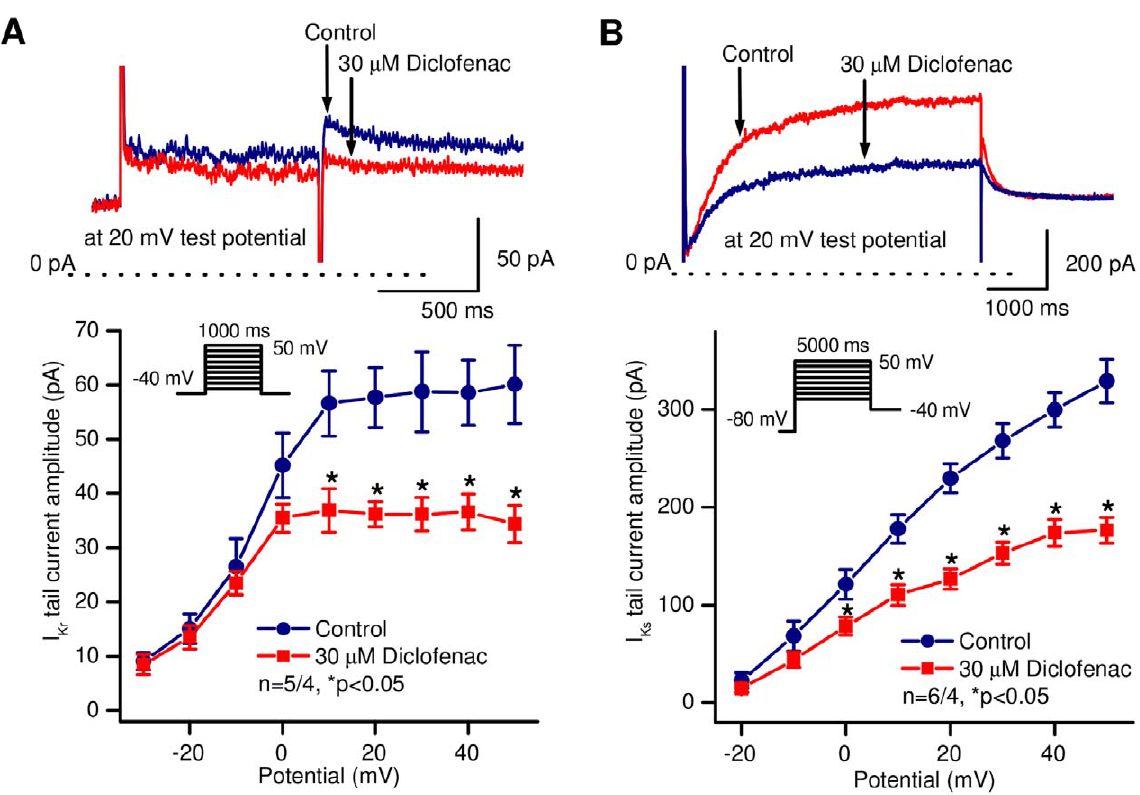
Figure 5. Effect of diclofenac on the rapid (I Kr ) and slow (I Ks ) component of the delayed rectifier potassium currents in canine ventricular myocytes. Top panels show representative current traces (A, I Kr ; B, I Ks ), bottom panels represent current – voltage relationships under control conditions and in the presence of 30 m M diclofenac. Insets indicate the voltage protocol applied during measurements. Data are expressed as mean 6 SEM, n=number of measurements/number of animals.